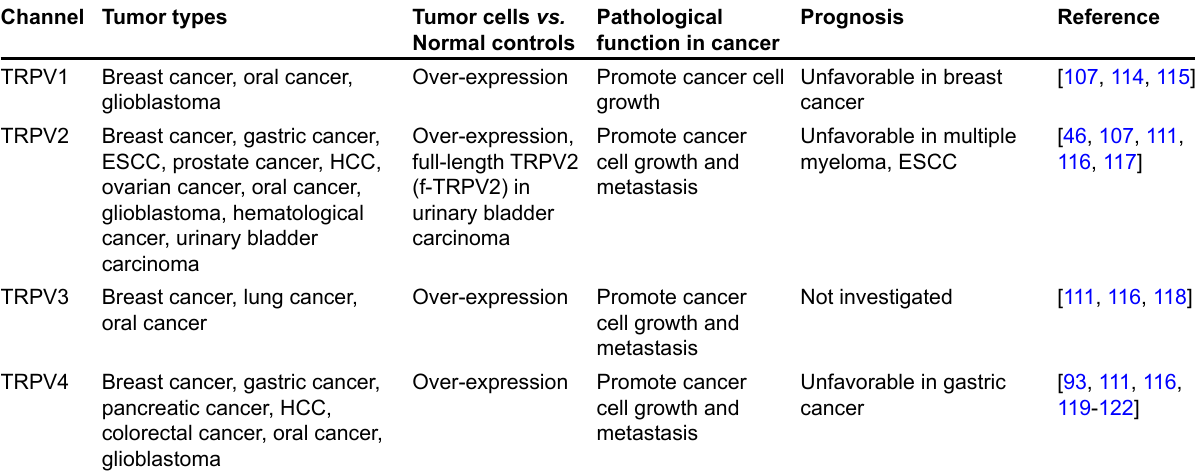
Table 2. Nociceptive TRP channels in regulating cancer progression ( continued ) Channel Tumor types Tumor cells vs. Normal controls